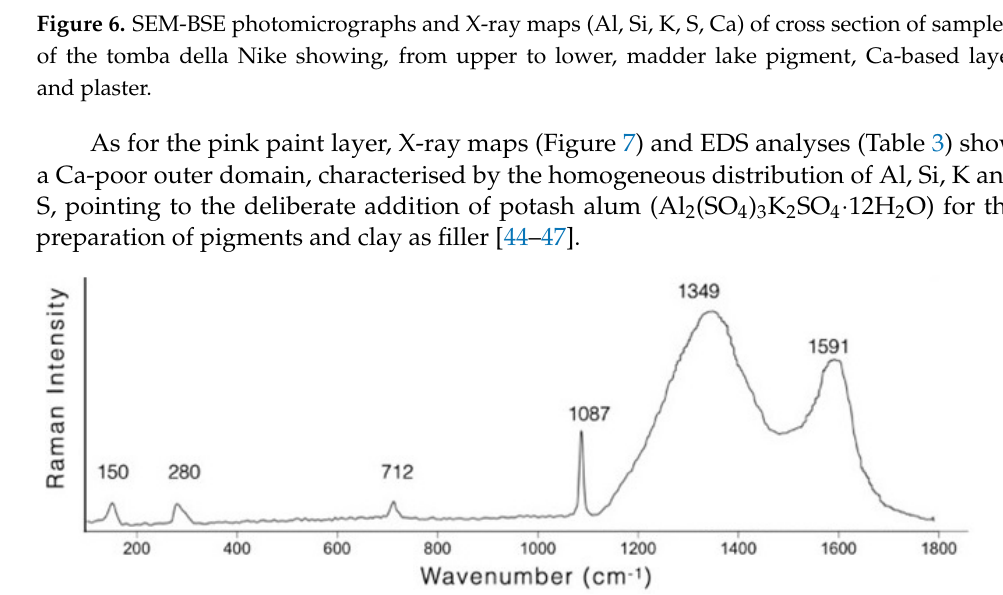
Figure 6. SEM-BSE photomicrographs and X-ray maps (Al, Si, K, S, Ca) of cross section of sample 1